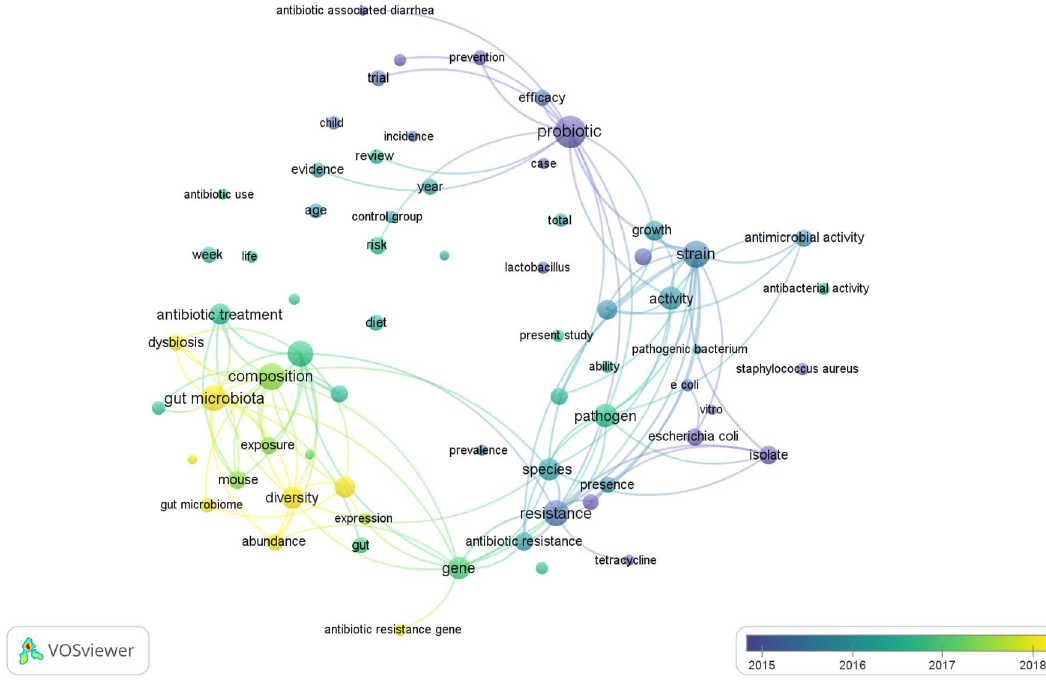
Figure 4. Overlay visualization map of the time sequence of frequently used terms in the microbiota and antibiotics (2002–2021). Yellow terms represent the most recent research.